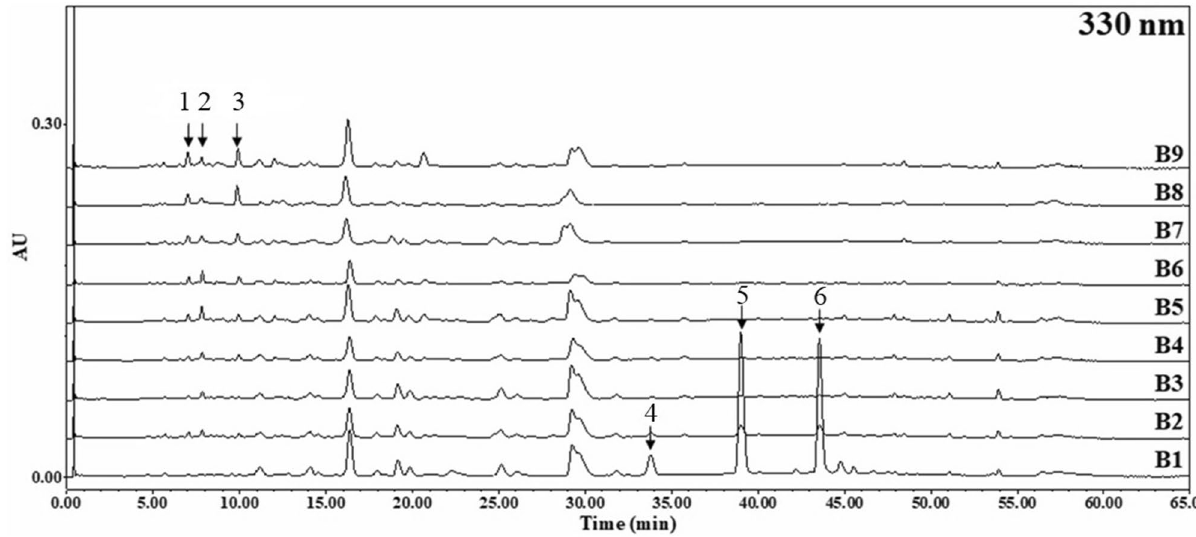
Figure 5. UPLC chromatogram at 330 nm for the comparison among samples of no germination (blank control; B1), DW-GBEs (B2, B3, B4, B5), and MRW-GBEs (B6, B7, B8, B9). The numbers of the peaks in this figure correspond to the compound numbers in Table 1.